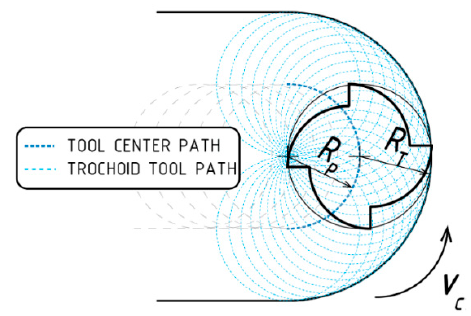
Figure 1. Geometric representation of the tool path [11], where: R T is the radius of the milling cutting tool; R P is the radius of the milling cutting circle.